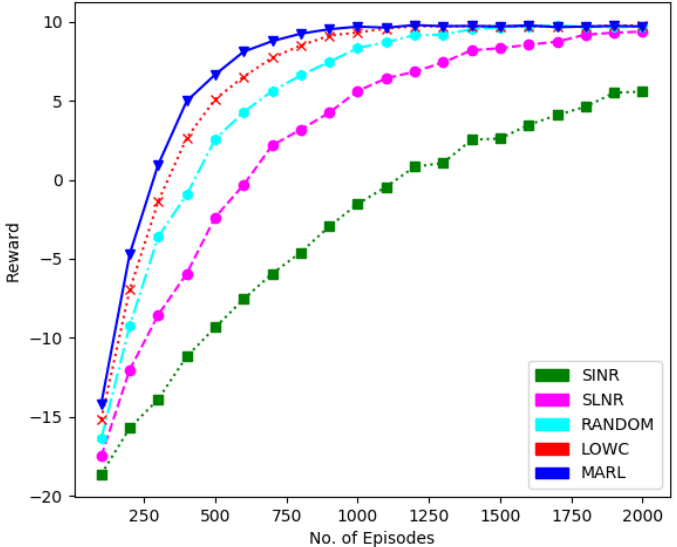
Figure 6. Sumrate performance comparison of different techniques for 30 users, five receive antennas at BS and one transmit antenna at each